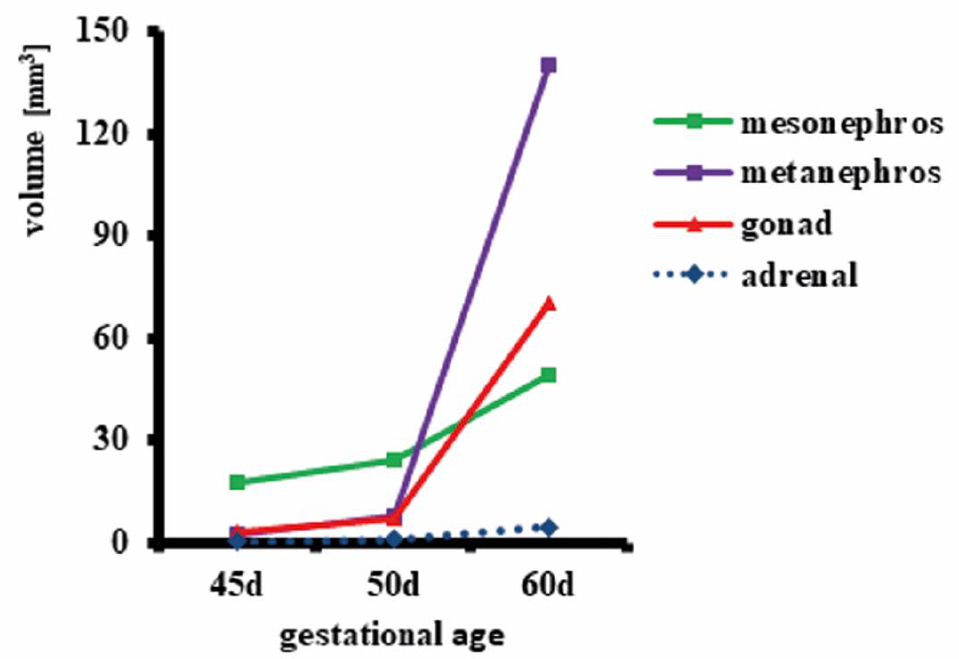
Figure 2. Size (volume) of mesonephros, metanephros, gonads and adrenal glands in female horse fetuses at 45, 50 and 60 days of gestation. After microCT scanning of one female fetus from each stage, image volumes were imported into Amira 6.4 and the urogenital region (mesonephros, metanephros, gonads, and adrenal glands) was divided using manual digital segmentation tools. Surface models were created from segmentation masks and volumes calculated by the software.